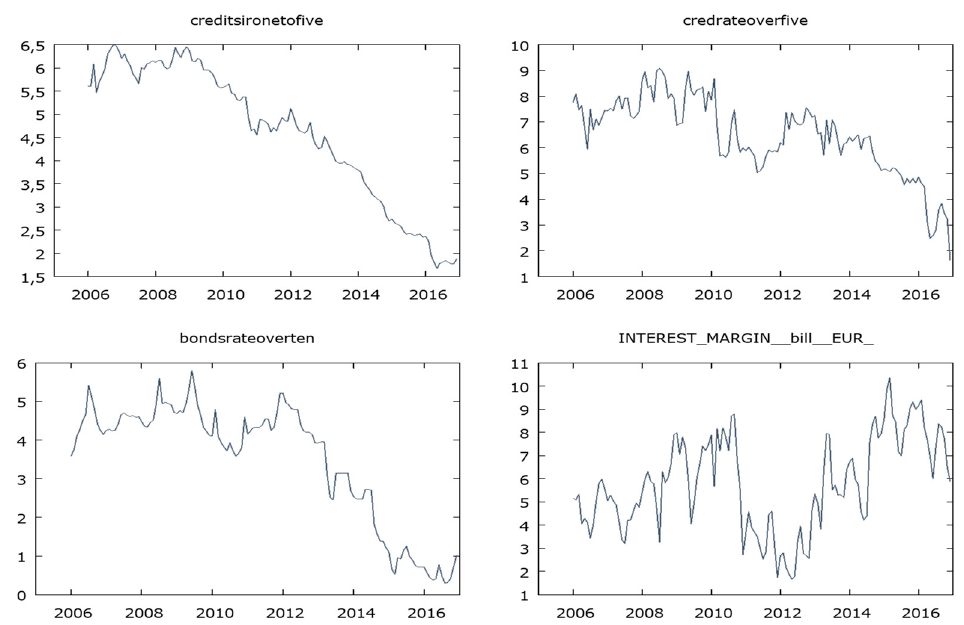
Figure 2. Interest rates on housing credits with maturity of one–five years (creditsironetofive), with maturity of over five years (credrateoverfive), mortgage bond rate with maturity of over ten years (bondsrateoverten) and interest margin (INTEREST_MARGIN) in the period 2006–2016.